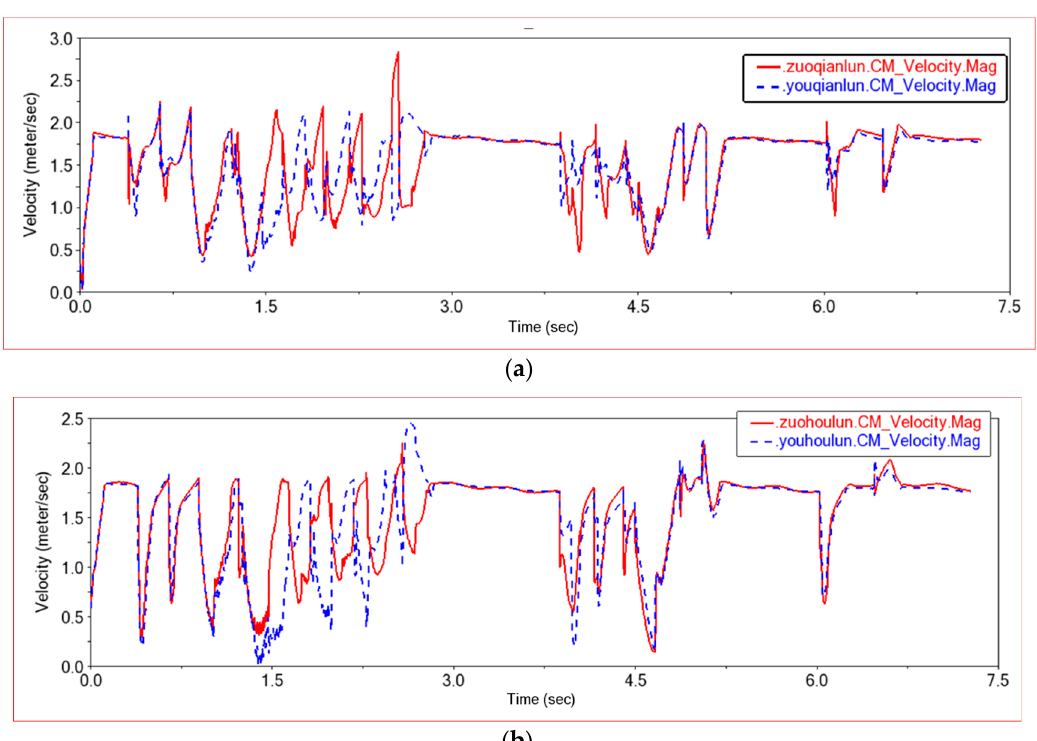
Figure 25. Wheel speed comparison curve in Experiment 3. ( a ) Front wheel speed curve, youqianlun.CM-Center of Mass of Right Front Wheel, zuoqianlun.CM-Center of Mass of Left Front Wheel; ( b ) Rear wheel speed curve, youhoulun.CM-Center of Mass of Right Rear Wheel, zuo- houlun.CMCenter of Mass of Left Rear Wheel.